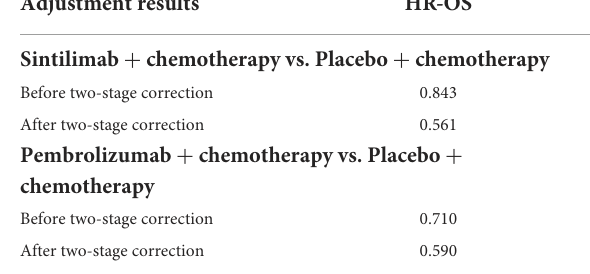
FIGURE1 Partitioned survival model structure.